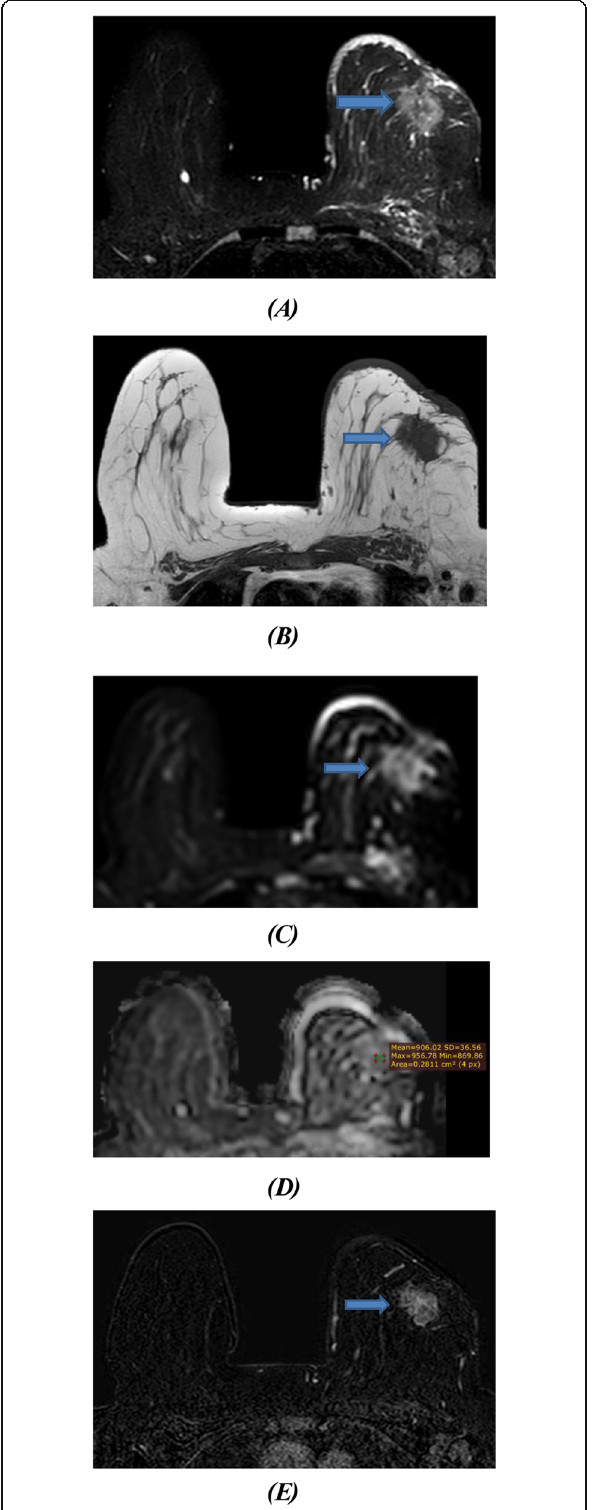
Fig. 1 Female patient aged 50 years with history of left breast cancer underwent conservative breast surgery and then presented by palpable left breast mass. a Axial STIR image showed retroareolar lesion of intermediate signal intensity. b Axial T1WI, the lesion appeared of low signal intensity. c , d DWI and ADC map, the lesion appeared restricted with a mean ADC value = 0.9 × 10 – 3 mm 2 /s. e Subtraction MR image showed heterogeneously enhancing irregular shaped retroareolar mass. Pathological diagnosis revealed recurrent grade II invasive duct